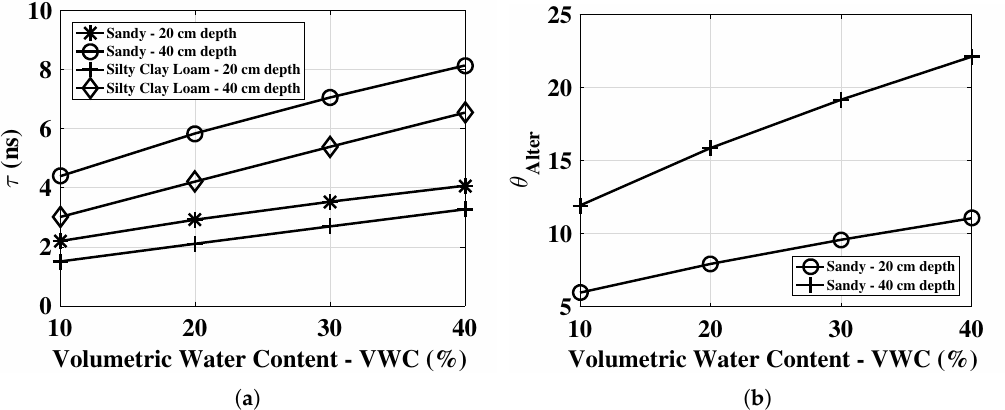
Figure 7. ( a ) τ with 10–40% change in soil moisture in sandy and silty clay loam soils at 20 cm and 40 cm depth. ( b ) Corresponding phase shift adjustment to original phase in sandy soil for 10–40% change in soil moisture at 20 cm and 40 cm depth.